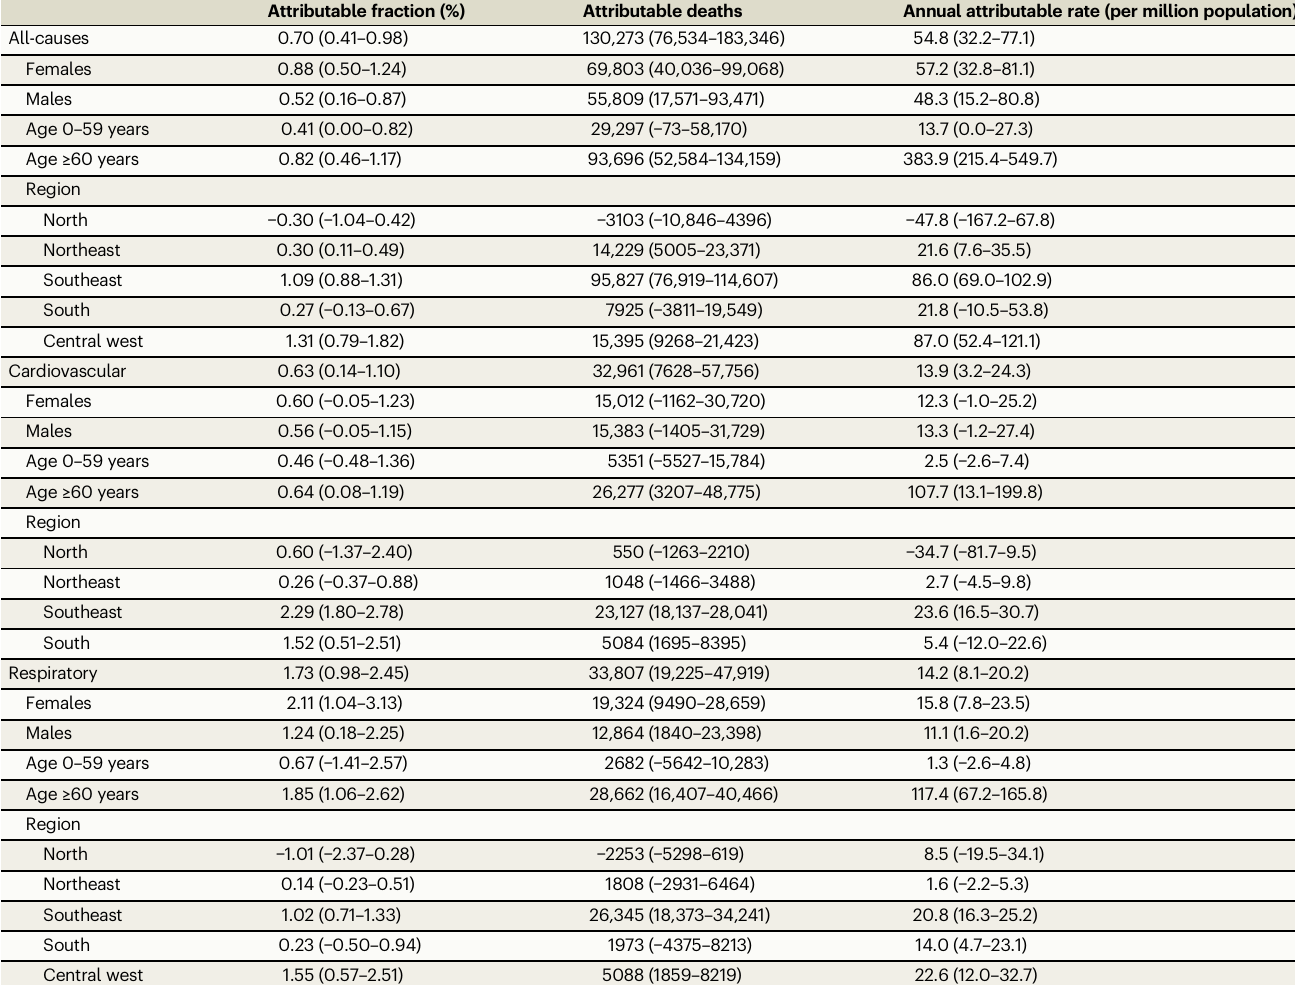
Table 2 | Attributable fractions and attributable mortality (with 95% con fi dence interval [CI]) associated with short-term wild fi re-related PM 2.5 in Brazil during 2000 ‒ 2016 by cause, sex, age, and region Attributable fraction